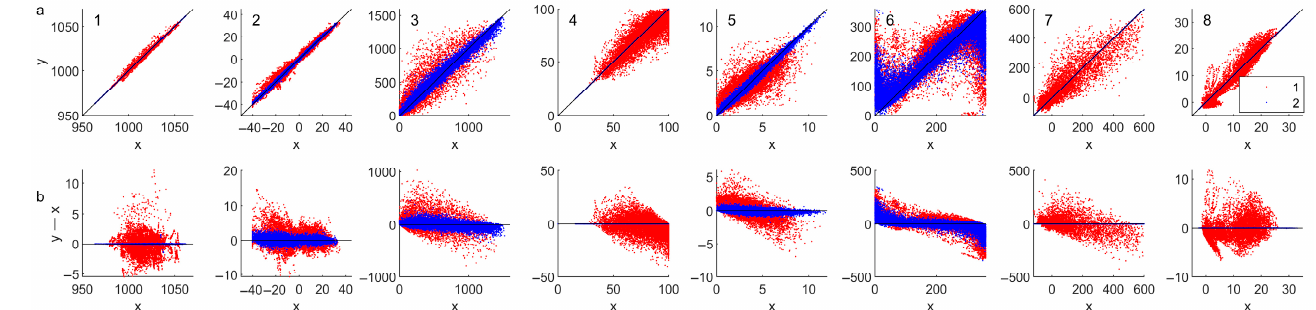
Figure 9. The comparison of observed (x) and modelled (y) meteorological variables from the GPRexp model based on the ERA dataset. 1—air surface pressure (hPa), 2—air temperature (°C), 3—incoming photosynthetically active radiation (µmol/m 2 /s), 4—relative air humidity (%), 5—wind speed (m/s), 6—wind direction (deg), 7—net radiation (W/m 2 ), 8—soil temperature at 5 cm (°C); blue—training subset; red—validation subset, ( a ) observed (y) vs. modelled (x), ( b ) error (y − x) vs. modelled (x).